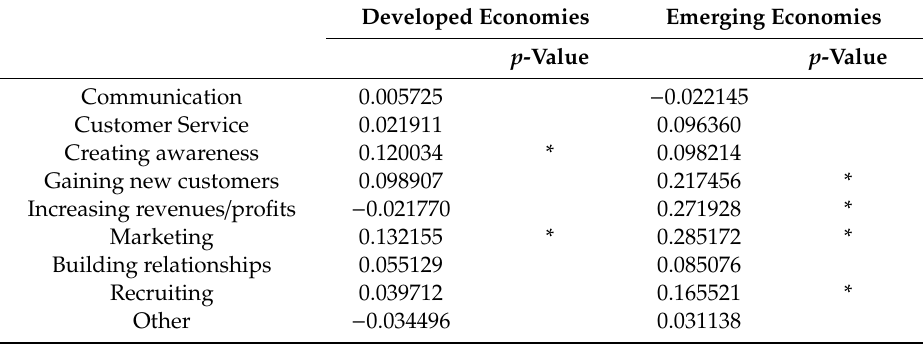
Table 3. Correlation relations between Facebook purposes of usage and age of